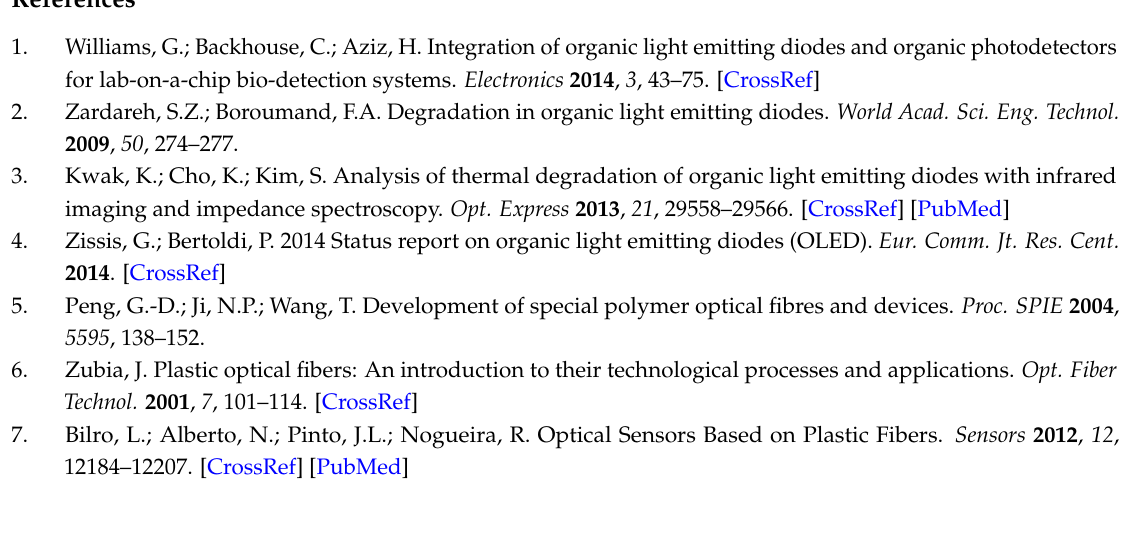
Figure 6. The luminescence signal attenuation vs. fiber length.